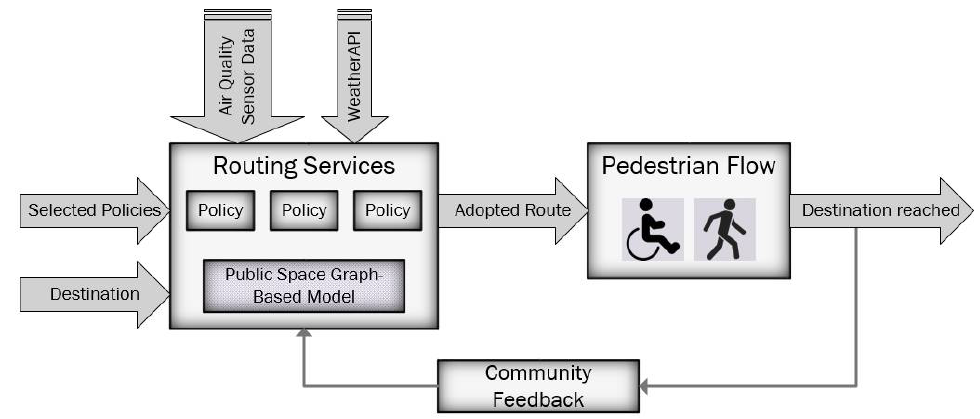
Figure 1. Pedestrian routing system .